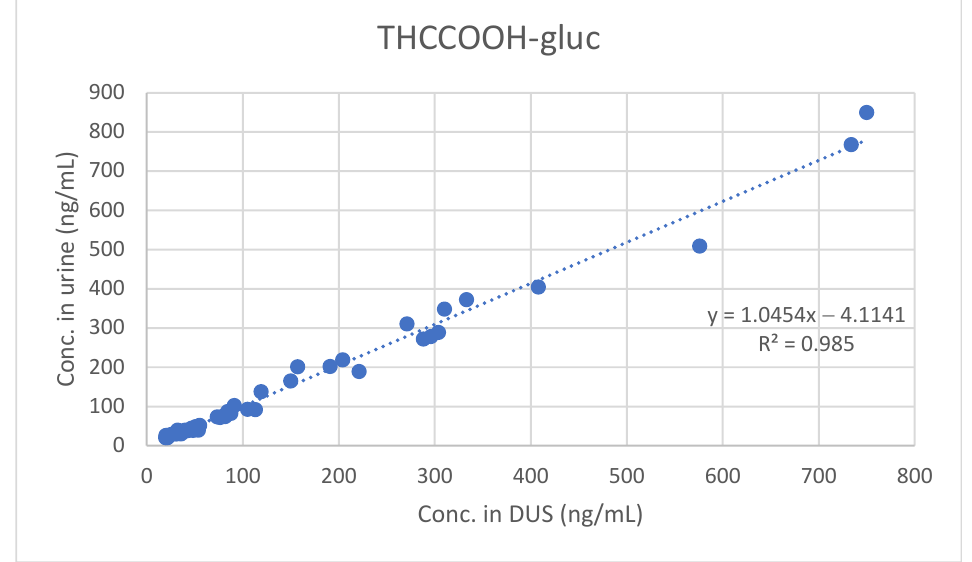
Figure 3. Comparison between urine and DUS concentrations of THCCOOH-gluc. A Bland–Altman plot, performed for all three analytes, proved good agreement between the two different urine measurements (see Figures 4–6).